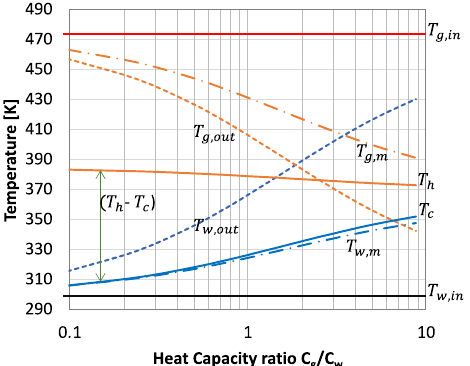
Figure 11. Temperature distribution vs heat capacity ratio. The temperatures of water inlet and hot-gas inlet are constant. As hot-gas heat capacity increases, the entire temperature decreases on the hot-gas side and increases on the water side. At some point, the outlet temperature of gas and water switched over. Therefore, around that point, the heat harvesting strategy may change, and most of the hot-gas heat is transferred to the water.